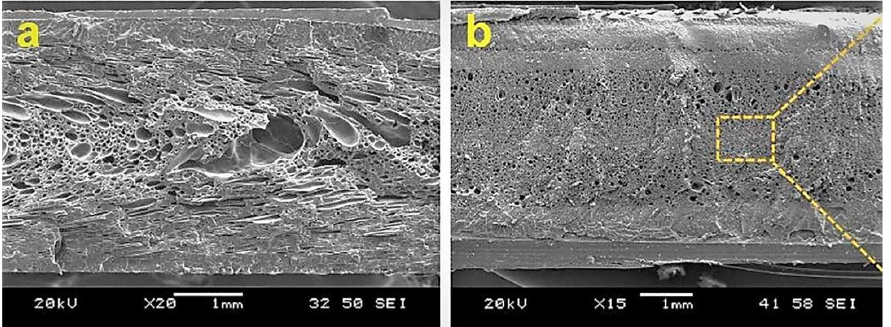
Figure 5. Scanning electron microscopy (SEM) image of foamed samples: ( a ) pure PLA foam prepared by regular micropore injection molding, ( b ) pure PLA foam High-pressure microwell injection molding (reproduced with permission from Reference [79], Copyright 2022 Elsevier).